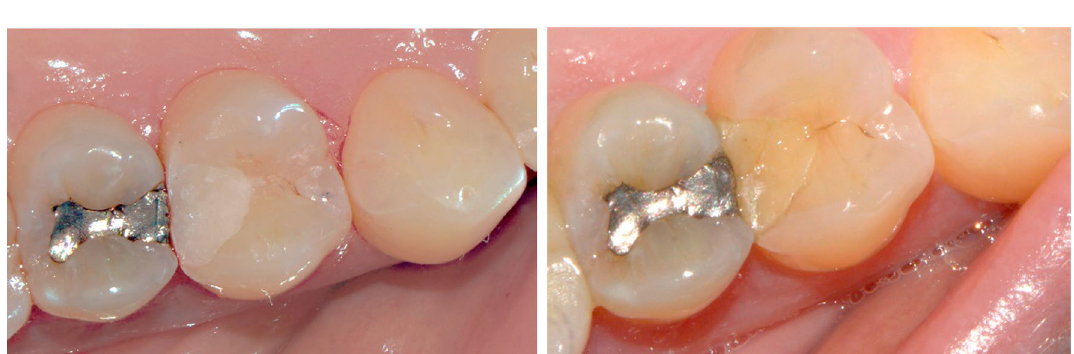
Figure 1. Class II restoration in upper first premolar at baseline (left) and 1-year recall (right). Color change and occlusal steps at the enamel margin were visible after 1